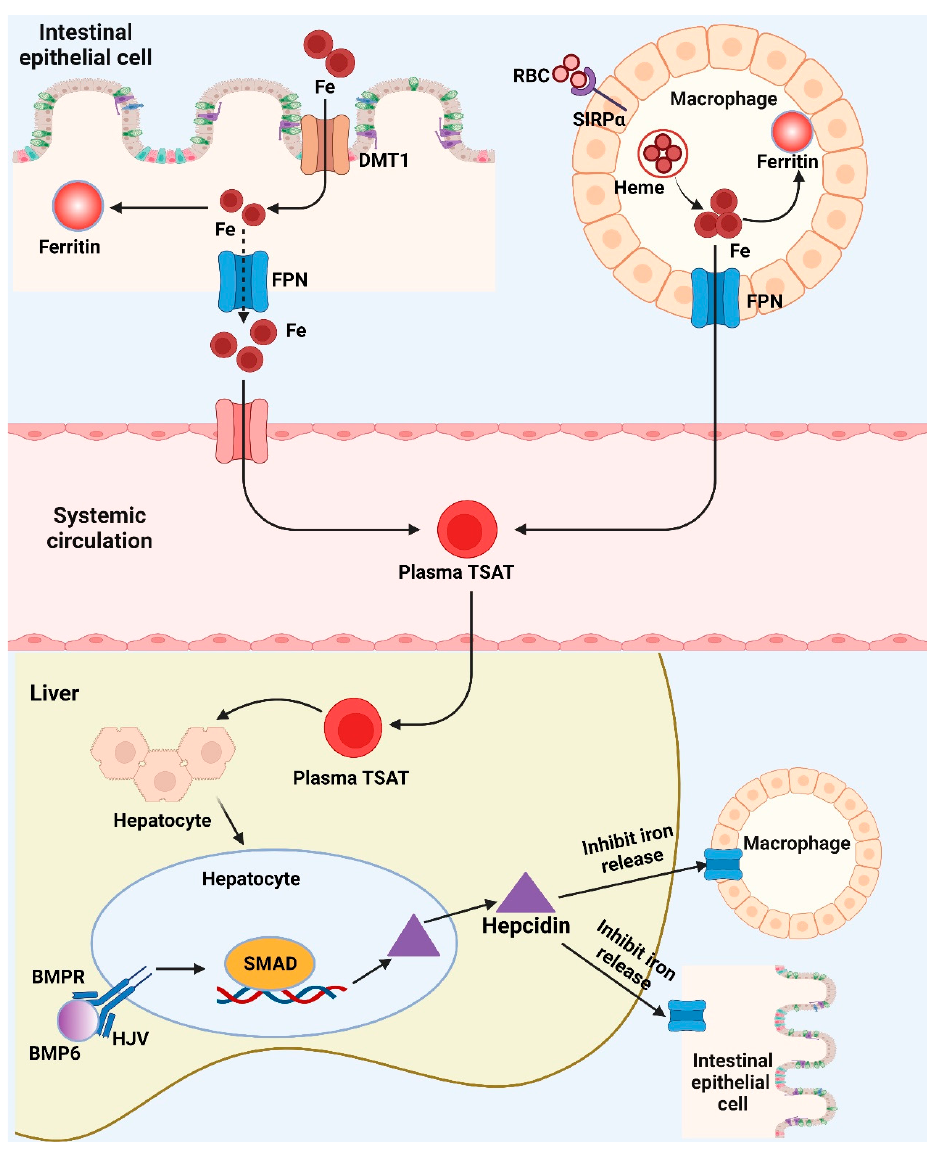
Figure 3. Brief depiction of the systemic iron metabolism and potential iron biomarkers. (Created with BioRender.com). BMP6: Bone morphogenetic protein 6; BMPR: Bone morphogenetic protein receptor; DMT1: Divalent metal transporter 1; Fe: Iron/Ferrum; FPN: Ferroportin; HJV: Hemojuvelin; RBC: Red blood cell; SIRP α : Signal regulatory protein alpha; SMAD: Small-body-size mothers against decapentaplegic homolog 1; TSAT: Percentage transferrin saturation.